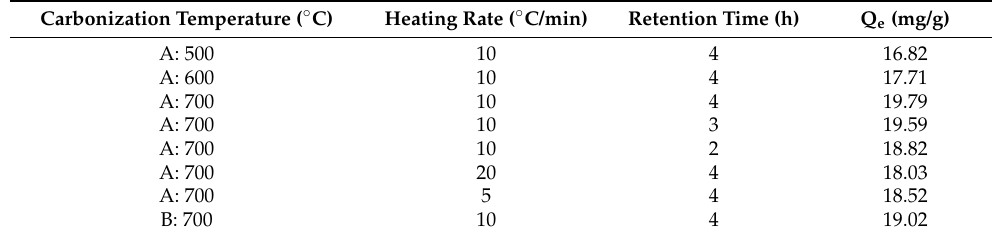
Table 2. Comparison of Cu(II) adsorption capacity of BC composites prepared by different methods.